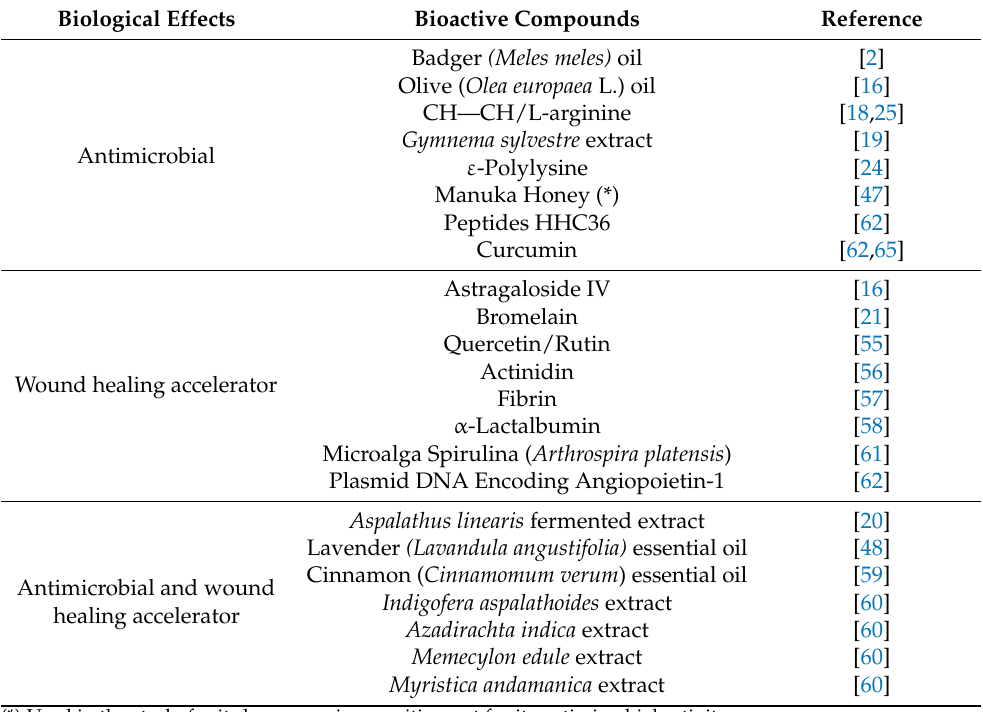
Table 4. Natural bioactive compounds with antimicrobial properties and/or which accelerate burn wound healing loaded in electrospun